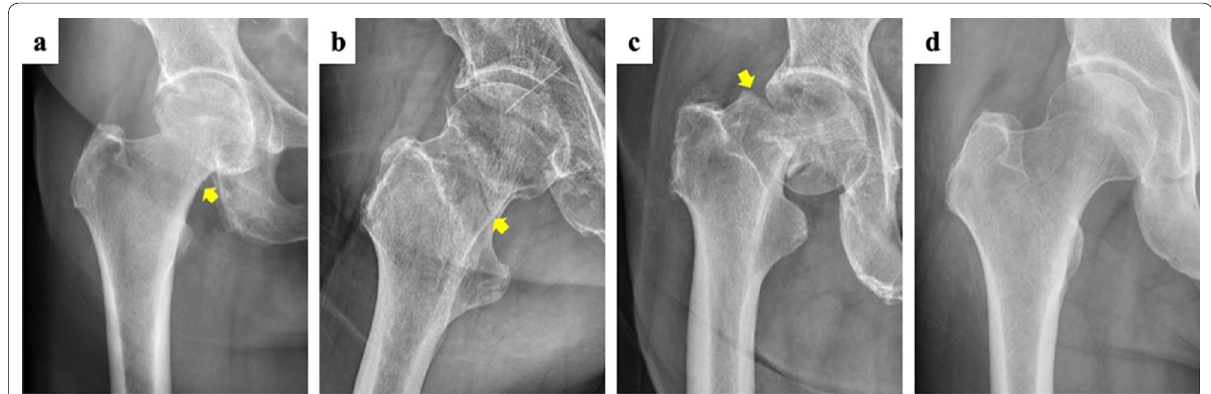
Fig. 1 Sample X‑ray images. Images of varying levels of difficulty, as judged by our expert radiologist and orthopediatrician. There were three levels of difficulty: difficult (level III, a ), medium (level II, b ), easy (level I, c ), and healthy images as the control ( d ). Arrow indicates the fracture line (not shown to the